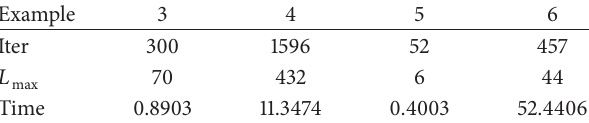
Table 2: 𝛼 = 0.5 ; the reduction cut is not adopted.